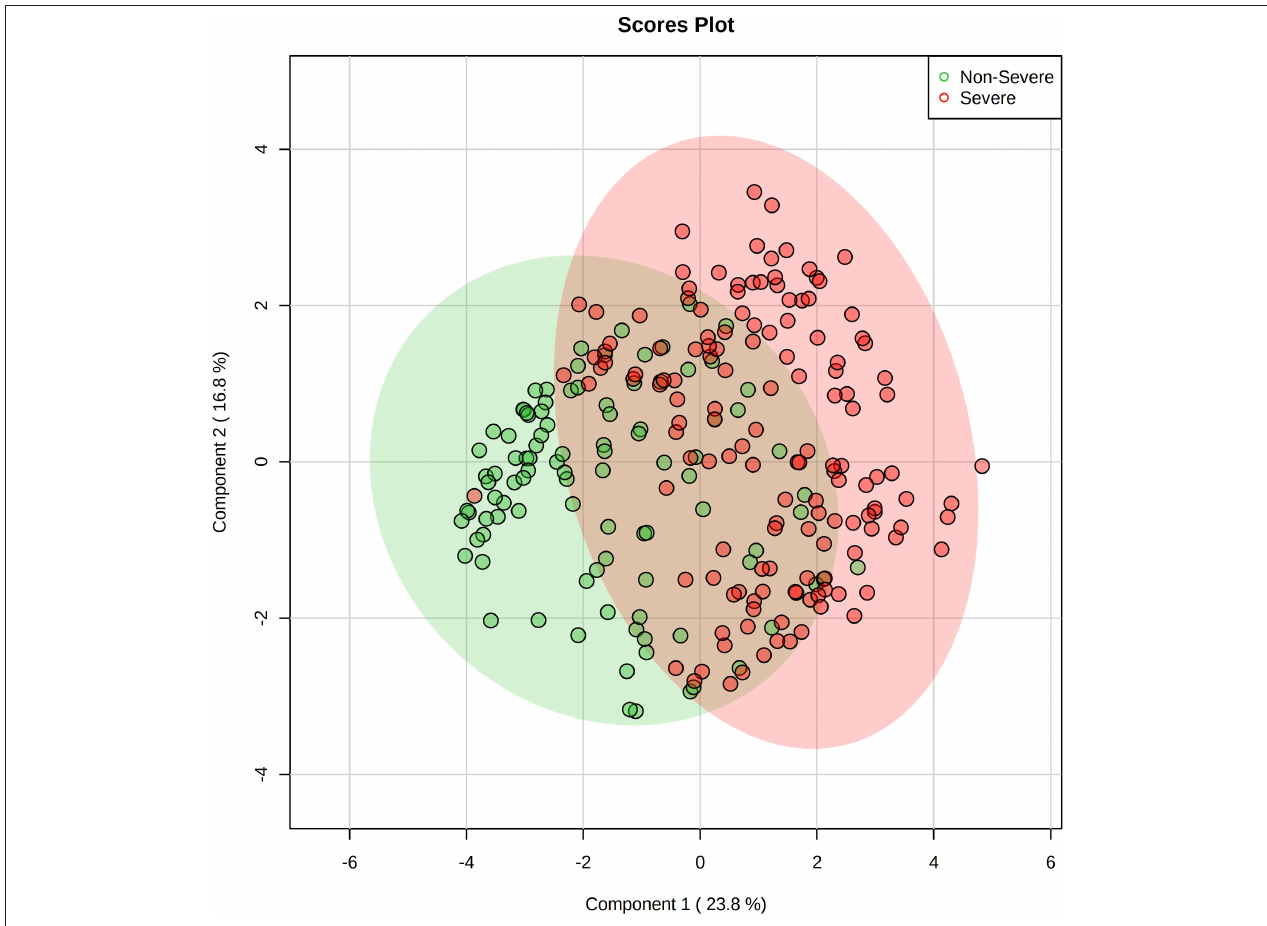
FIGURE 2 | Supervised dimensionality reduction using partial least square-discriminant analysis (PLS-DA) showing the principal components (PC) score plot for non-severe (green) and severe (red) COVID-19 patients. Shaded areas show the 95% confidence regions, with 23.8% of variance explained by PC1 and 16.8% by PC2. Figure generated using MetaboAnalyst 4.0